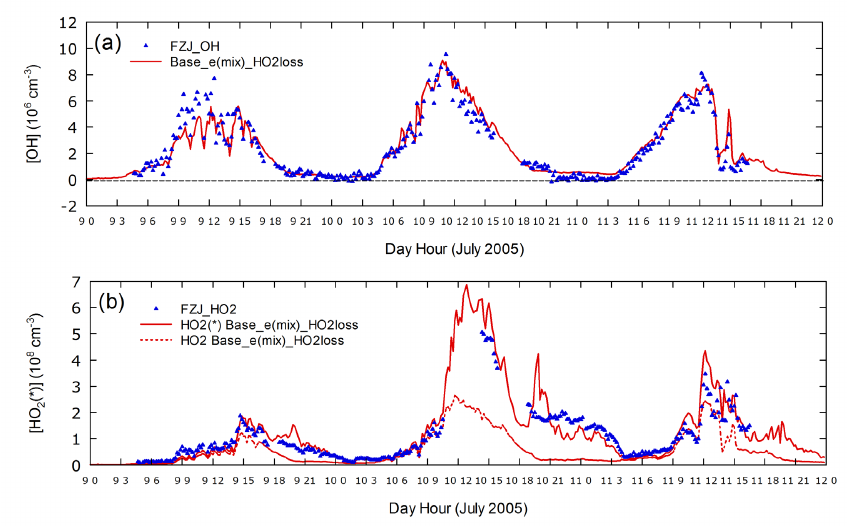
Fig. 7. Time series of observed OH and HO 2 by FZJ instrument, and modeled OH and HO 2 (*) in the Base e(mix) HO 2 loss run. Modeled HO 2 is also shown for reference.